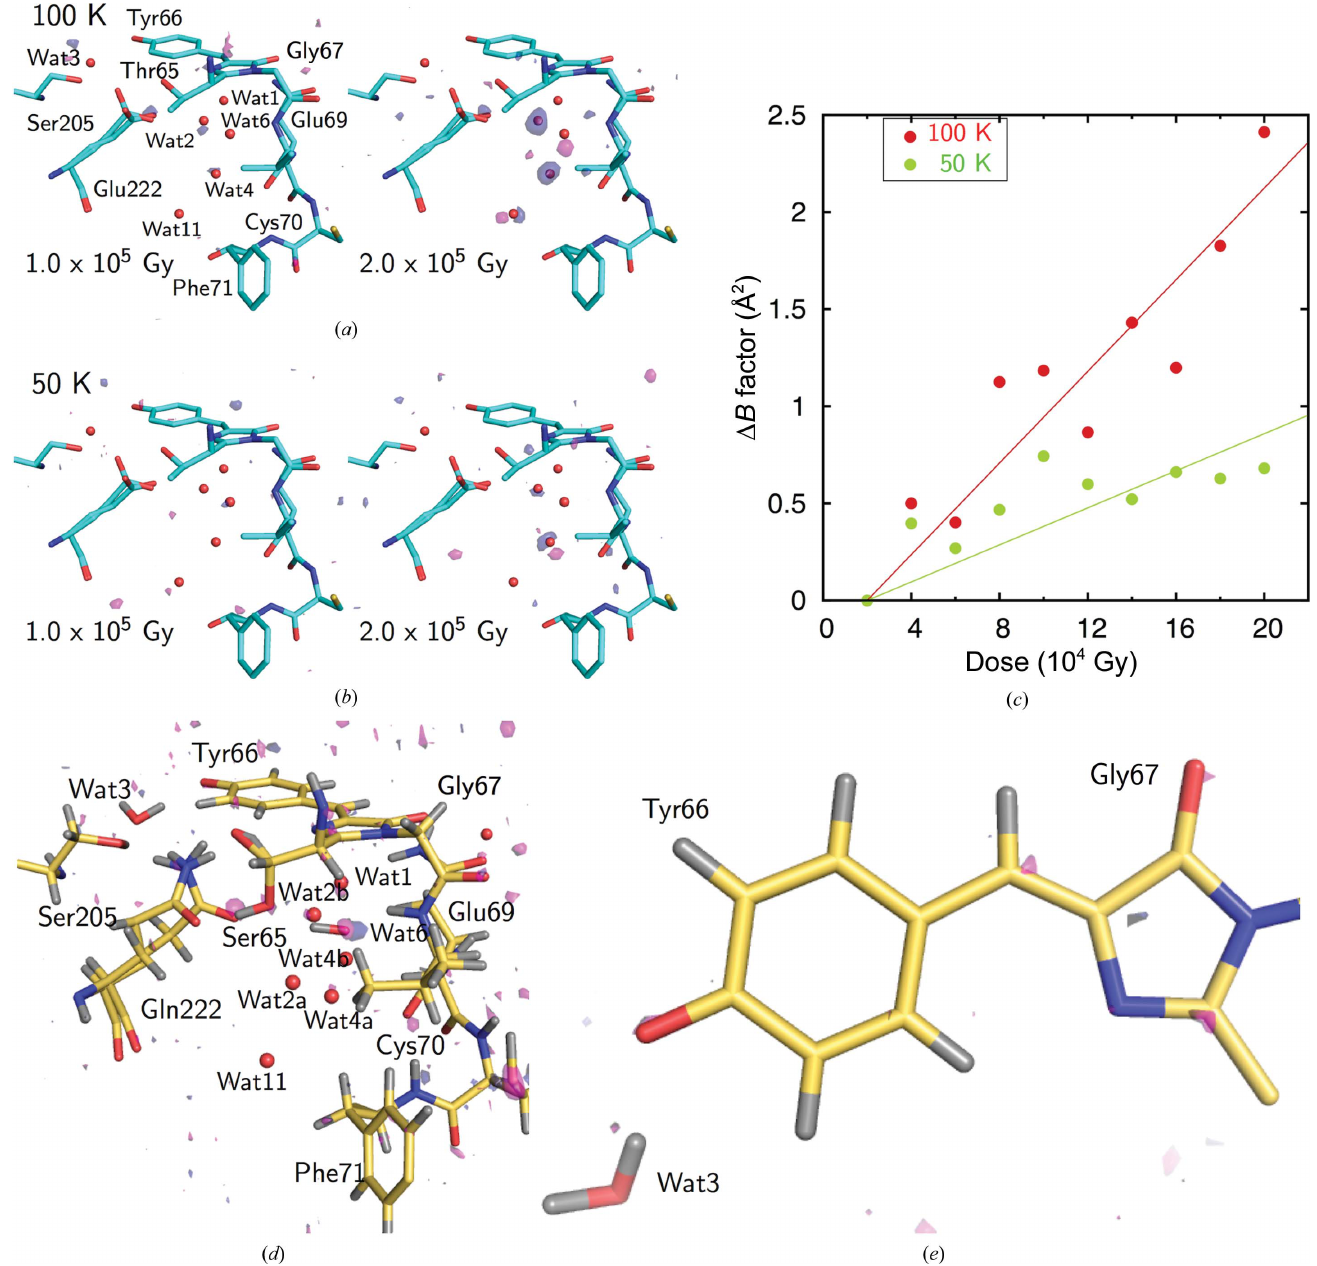
Figure 2 The effect of radiation on the chromophore of GFP. ( a , b ) Fourier difference maps of the S65T variant between the initial data set and the irradiated data set at 100 K ( a ) and 50 K ( b ). Positive density contoured at 3.5 (cid:5) is shown in magenta, while negative density contoured at (cid:5) 3.5 (cid:5) is shown in dark blue. The occupancy of the minor conformation of Glu222 is 0.25. ( c ) The relationship between the X-ray dose and the change in temperature factor averaged for the specific atoms O (cid:4) 1 of Glu222, Wat2 and Wat4. ( d , e ) The Fourier difference map of the E222Q variant between the first and second halves of the data set. The occupancies of the minor conformations of Thr65 and Gln222 are 0.05 and 0.22, respectively. ( d ) is from the same point of view as ( a ) and ( b ), while ( e ) is from a perpendicular direction to the plane of the chromophore. The data sets were collected at 60 K. The cumulative dose of the latter data set was 1.4 (cid:3) 10 5